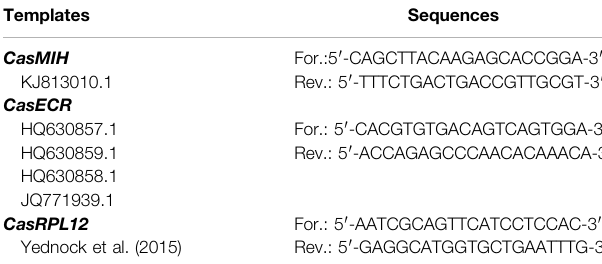
TABLE 1 | Primers ’ sequences and access numbers for the qPCR